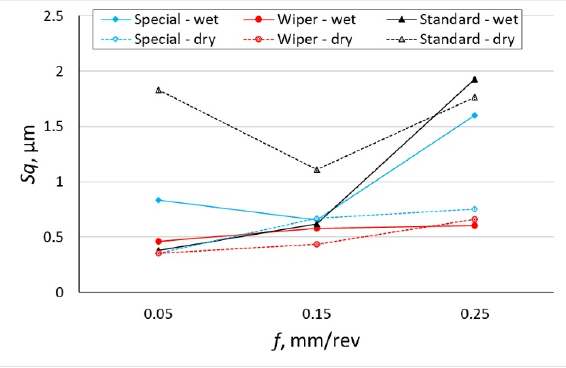
Figure 8. The impact of feed f on the variability of roughness parameter Sq .